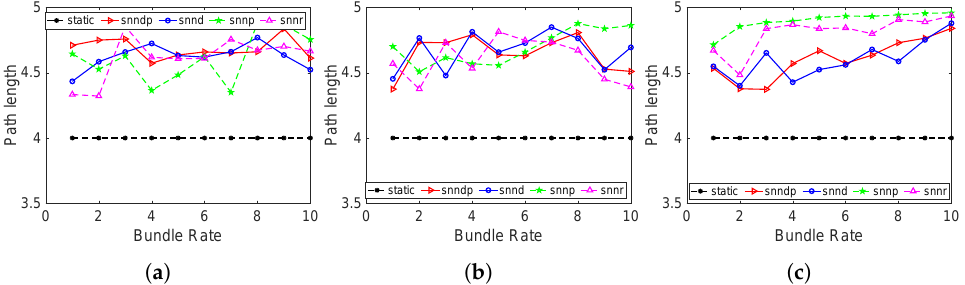
Figure 18. Path lengths traveled by bundles in Topology 2. ( a ) Scenario 7; ( b ) Scenario 8; ( c ) Scenario